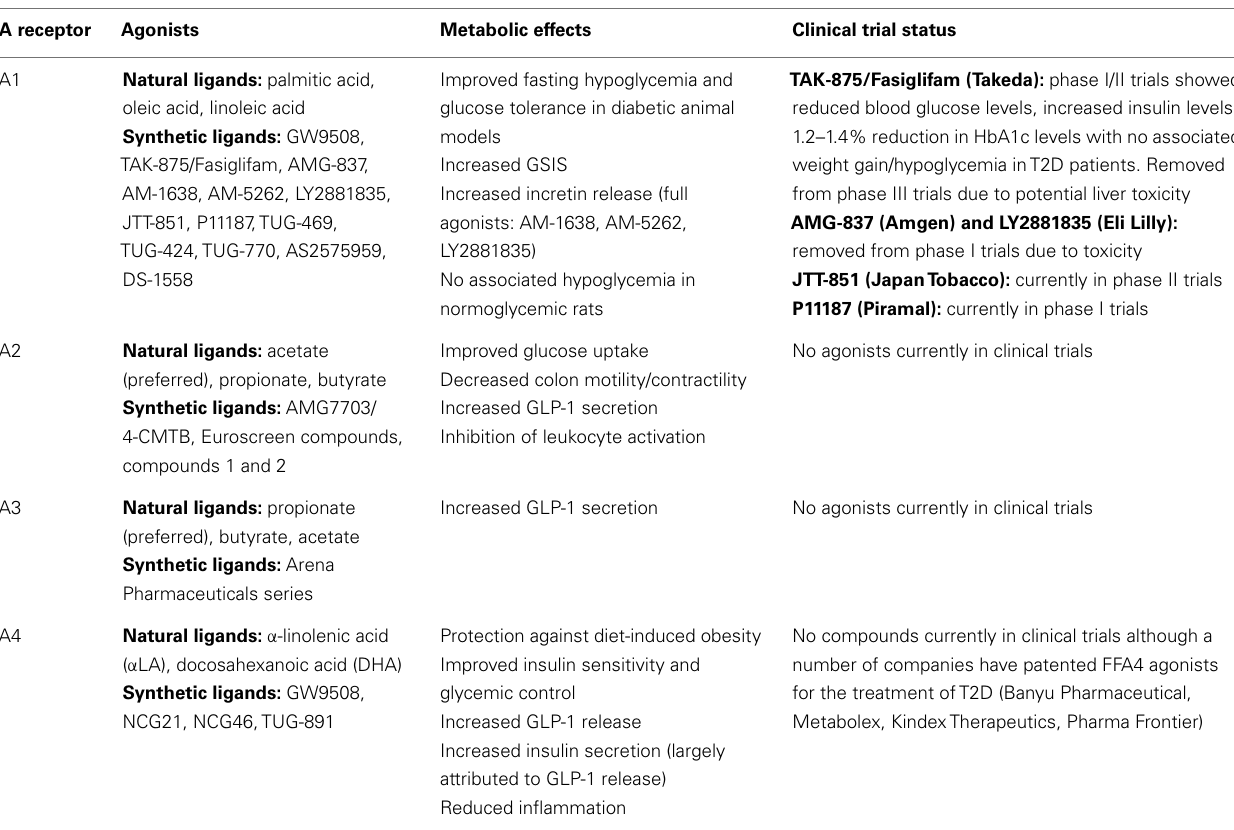
Table 1 | FFA receptor agonists for the treatment ofT2D